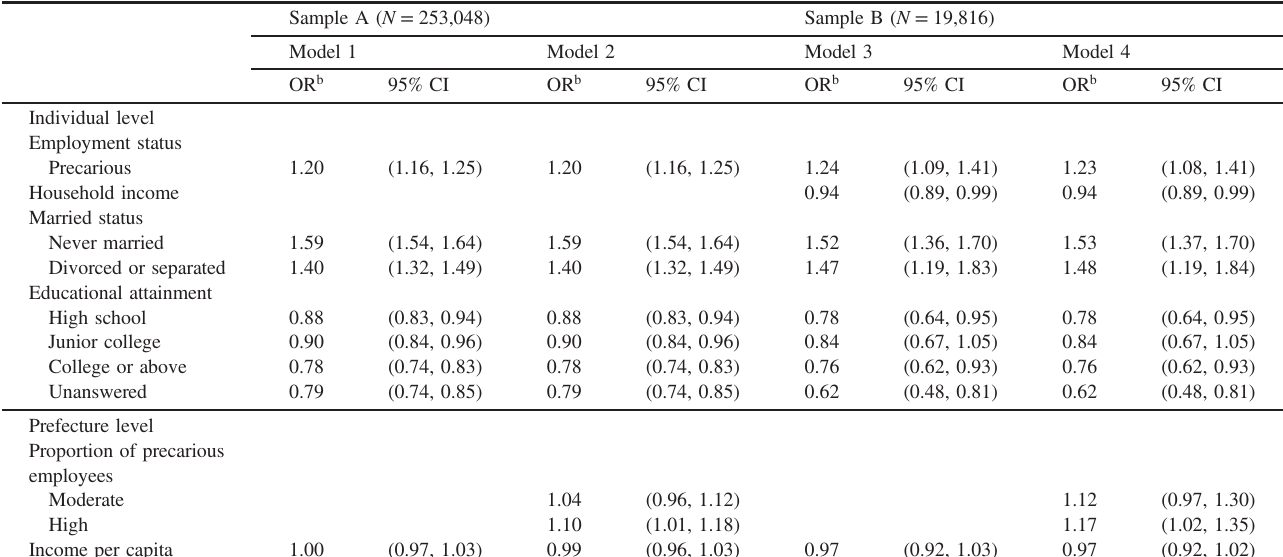
Table 4. Estimation results of multi-level logistic models to explain poor self-rated health for men a